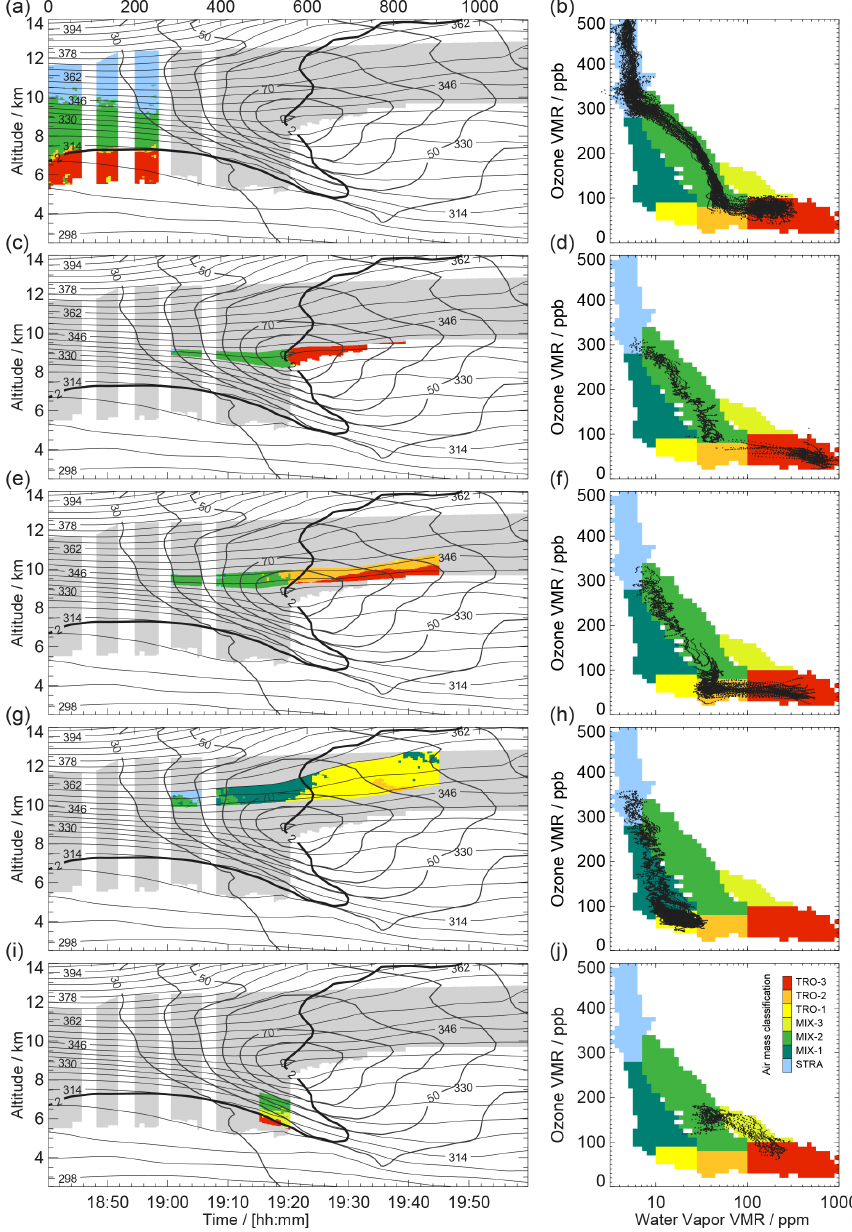
Figure 8. Data subsets of the collocated lidar data. (a, b) Before 19:00UTC with (a) showing the data as classified in Fig. 6 and in (b) as black dots superimposed on the classification of all data shown in Fig. 4c. (c, d) As (a) and (b) but for data in the time period from 19:00 to 19:45UTC in the layer 335–340K. (e, f) For 19:00 to 19:45UTC and 340–347K. (g, h) For 19:00 to 19:45UTC and 349–358K. (i, j) For 19:15 to 19:21UTC and